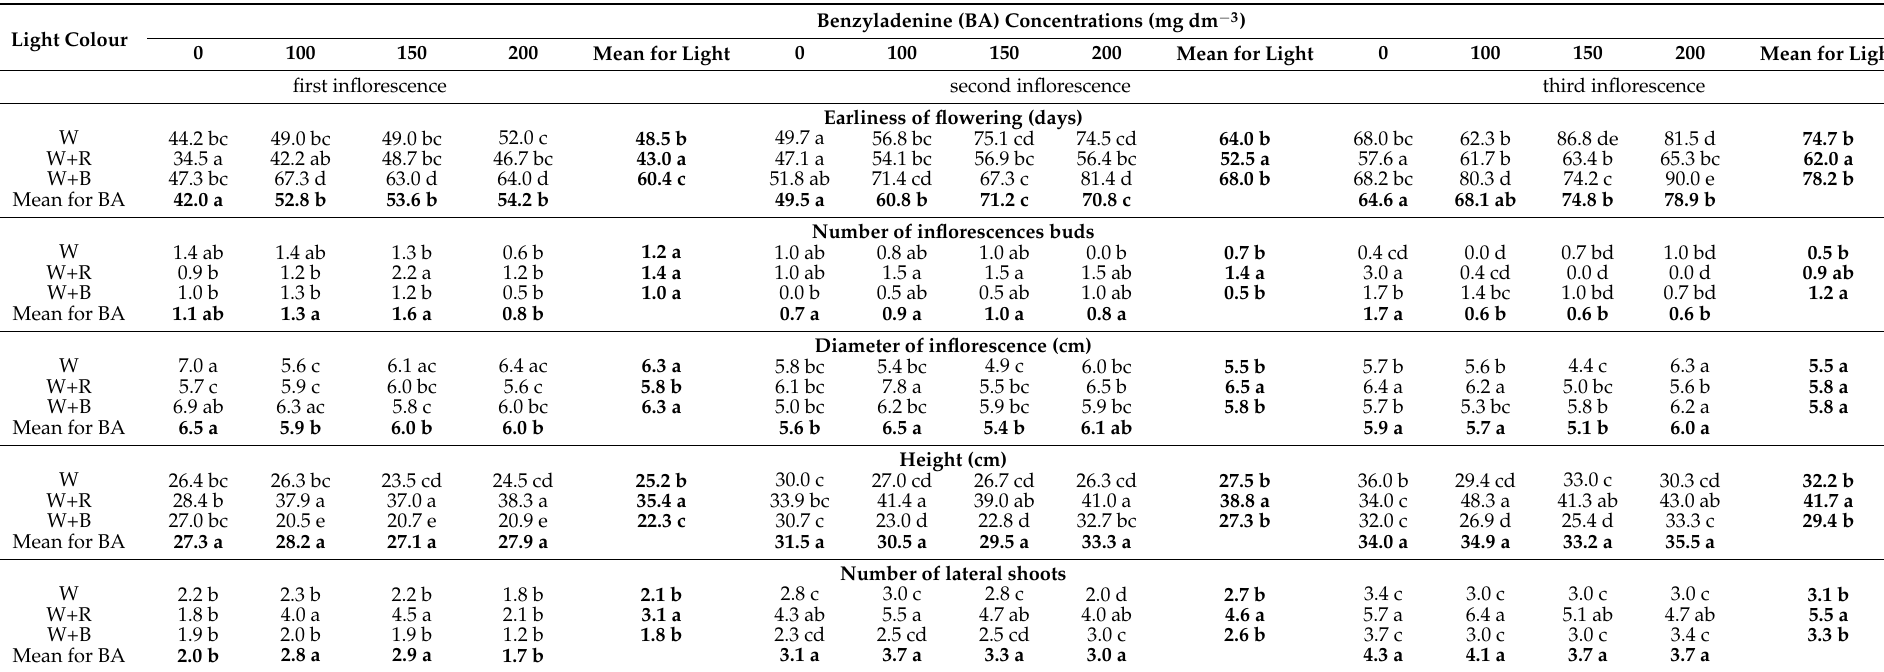
Table 2. Morphological parameters of Calendula officinalis “Radio” in depending on light colour and benzyladenine concentration. Light